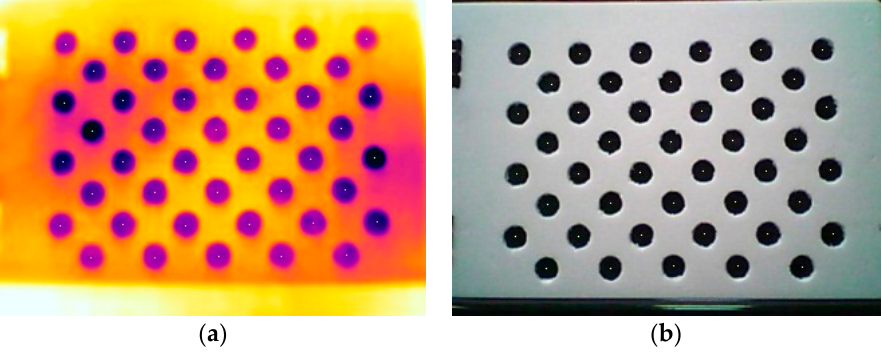
Figure 3. Calibration template for geometric translation: ( a ) false color thermal IR image; ( b ) gray scale visible image.